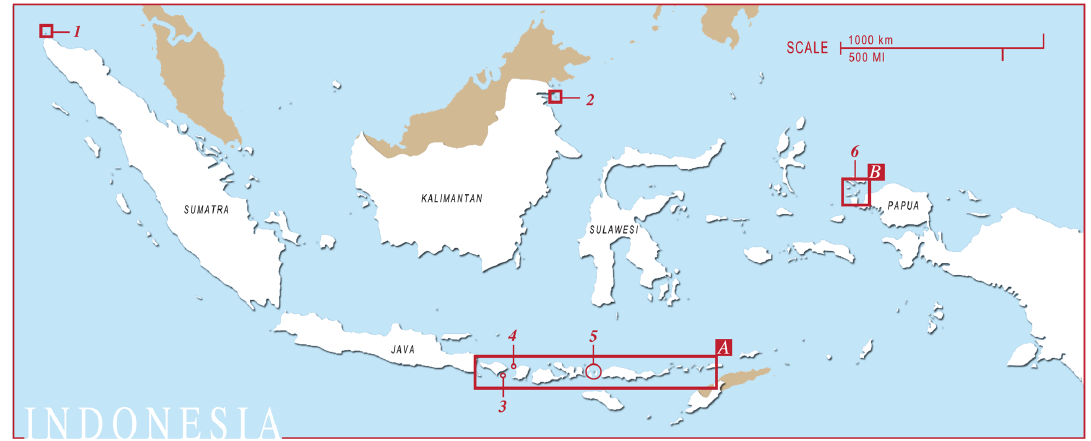
Figure 1. The locations of M.alfredi encounters in Indonesia submitted to Manta Matcher. Sites are numbered as follows: 1) Pulau Weh 2) Palau Sangalaki 3) Nusa Penida 4) Gili Islands 5) West Manggarai & Komodo National Park 6) Raja Ampat. (A) Connectivity area and commercial fisheries area (see Figure 2 for enlargement). (B) Region surveyed in Raja Ampat (see Figure 3 for enlargement).